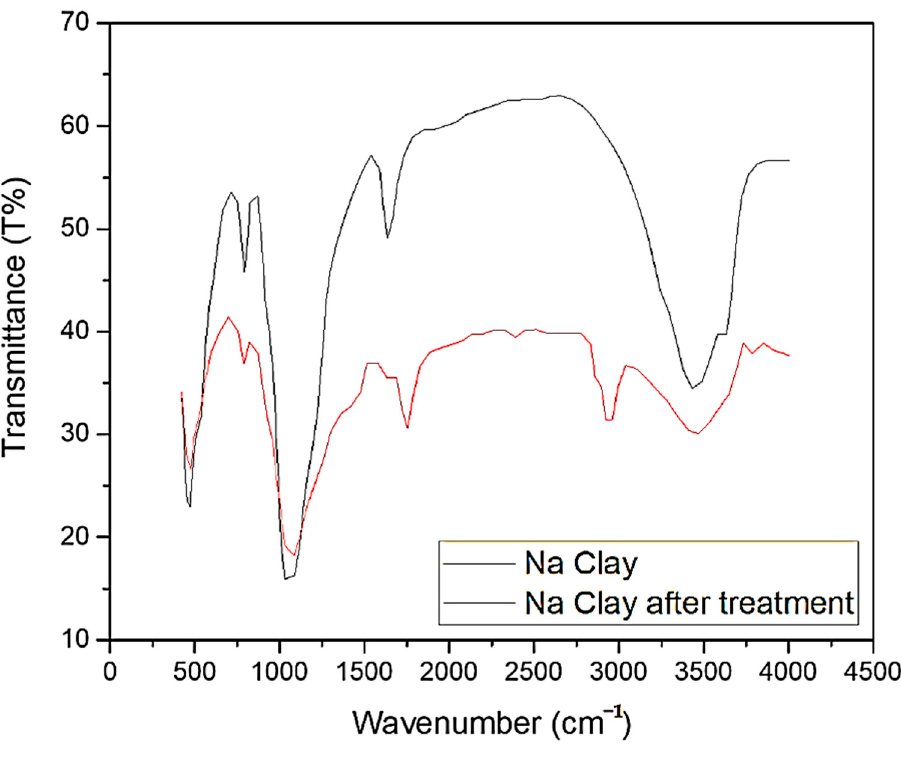
Figure 5. FT-IR of Na clay prior and after the UVO treatment (4 h).